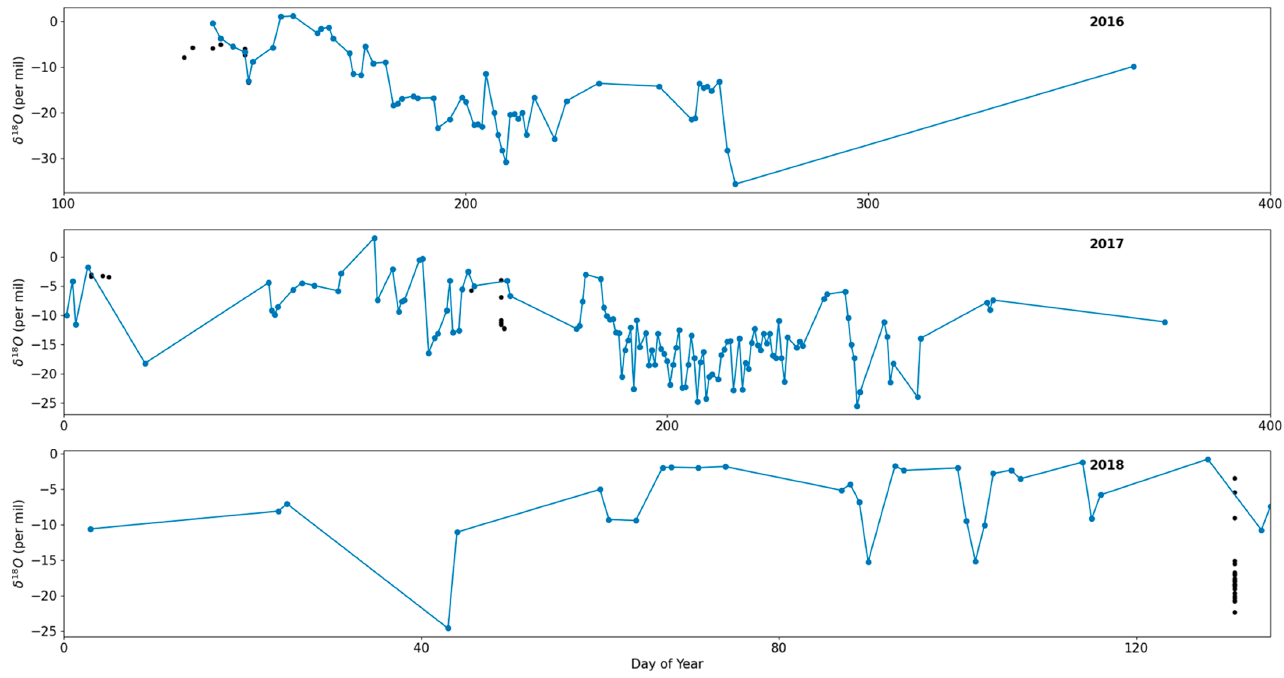
Figure 4. Overlay of precipitation δ 18 O (blue dotted curve) with that in surface snow (black dots) collected within a 50 m